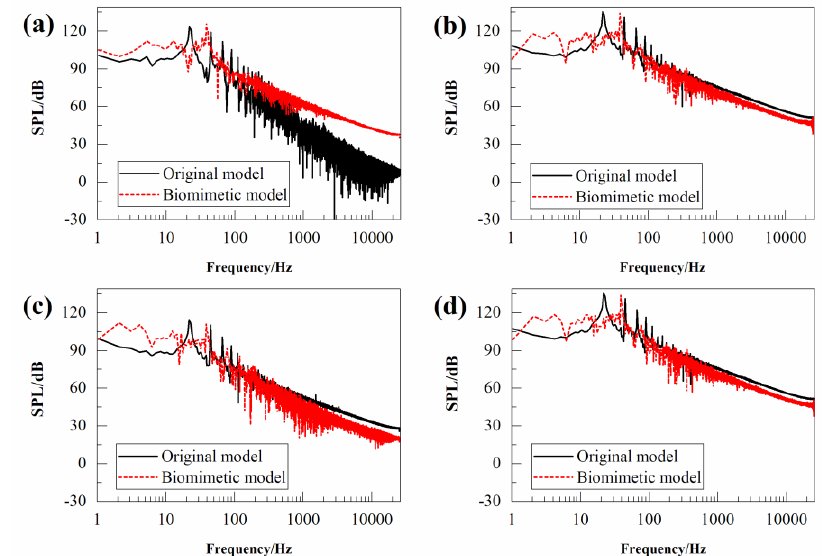
Figure 14. Comparison of the predicted SPL spectra of the original hydrofoil and biomimetic hydrofoil at the four observing points of the near sound field: ( a ) p 1 ; ( b ) p 5 ; ( c ) p 9 ; and ( d ) p 13 .